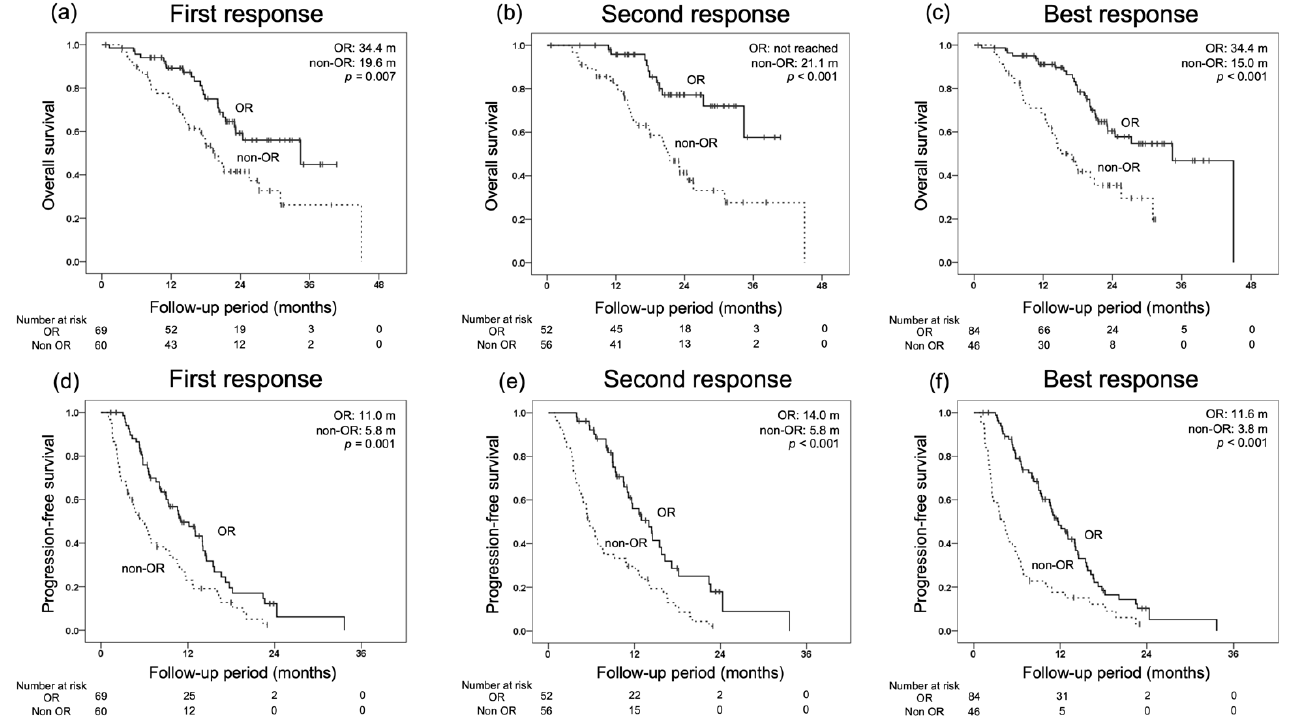
Figure 2. Comparison of overall survival (OS) and progression-free survival (PFS) by the response at the first, second, and best responses as evaluated by modified Response Evaluation Criteria in Solid Tumors (mRECIST). ( a ) OS at the first response (objective response (OR) 34.4 months, non-OR 19.6 months, p = 0.007). ( b ) OS at the second response (OR not-reached, non-OR 21.1 months, p < 0.001). ( c ) OS at the best response (OR 34.4 months, non-OR 15.0 months, p < 0.001). ( d ) PFS at the first response (OR 11.0 months, non-OR 5.8 months, p = 0.001). ( e ) PFS at the second response (OR 14.0 months, non-OR 5.8 months, p < 0.001). ( f ) PFS at the best response (OR 11.6 months, non-OR 3.8 months, p < 0.001).